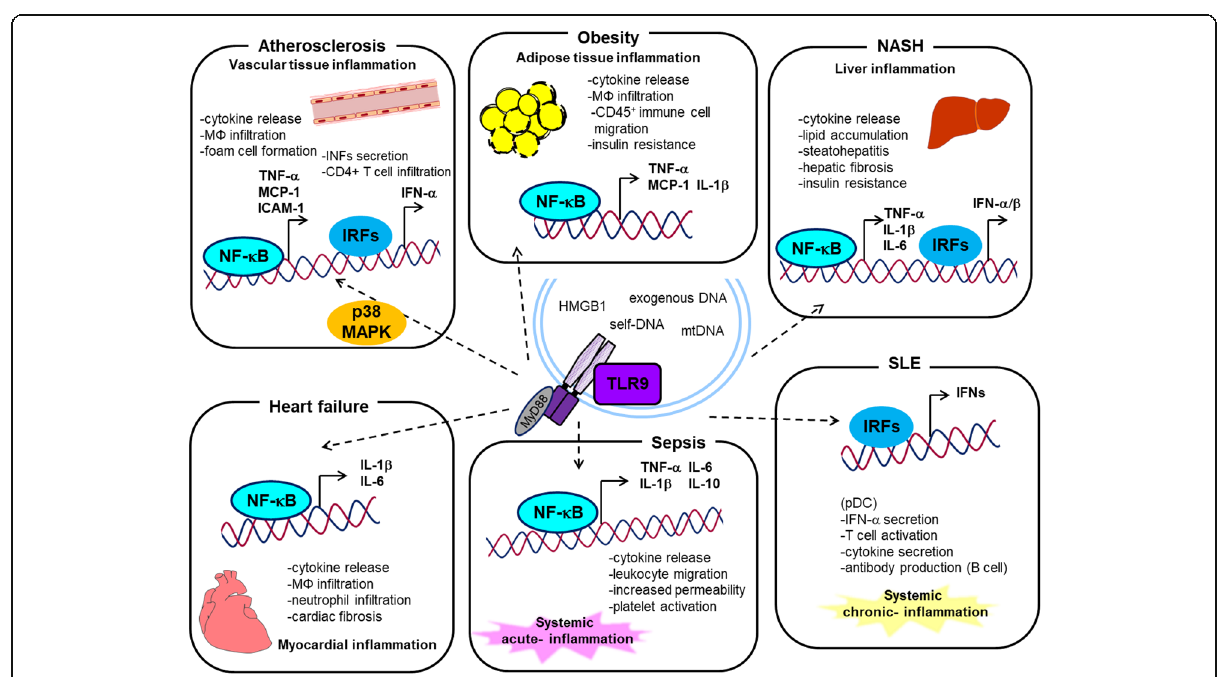
Fig. 2 TLR9 signaling in inflammatory diseases. Activation of TLR9 signaling in immune cells leads to release various cytokines and interferons in cardiometabolic organs and other tissues, participating in the pathogenesis of both infectious and sterile inflammatory